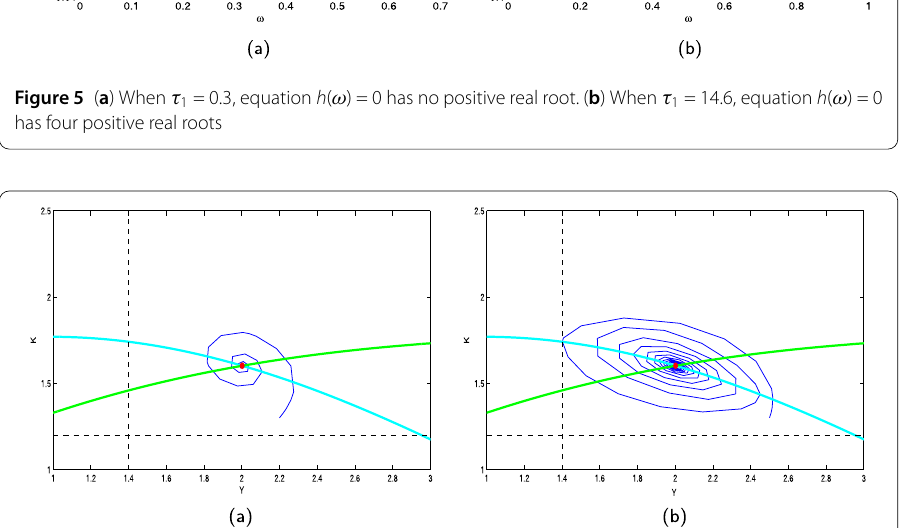
Figure 6 ( a ) τ 1 = 0.3 and τ 2 = 4.0, the positive equilibrium is asymptotically stable. ( b ) τ 1 = 0.3 and τ 2 = 12.6, the positive equilibrium is asymptotically stable